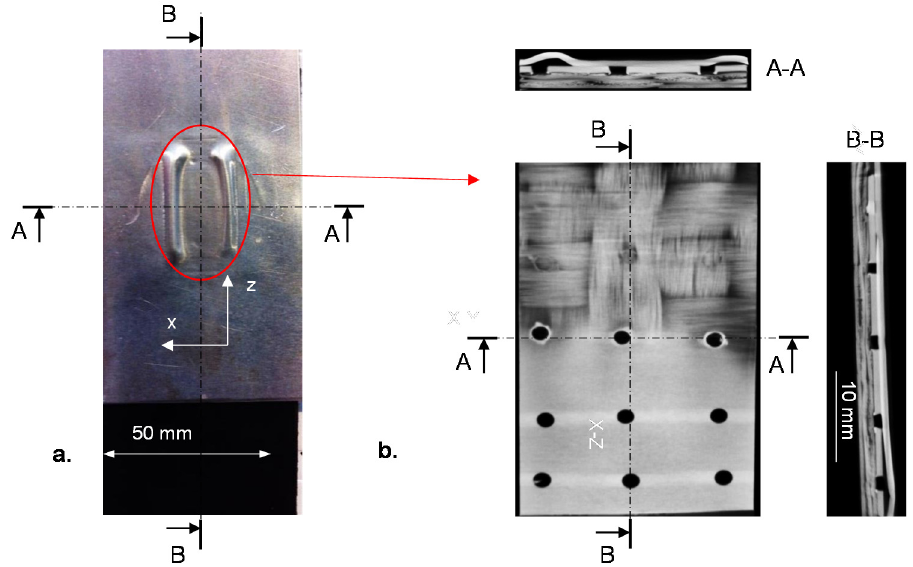
Figure 8. ( a ) MPSW specimen observed in top view; ( b ) Center of the MPSW specimen observed in top view and in A-A and B-B cross-sectional views by microtomography.